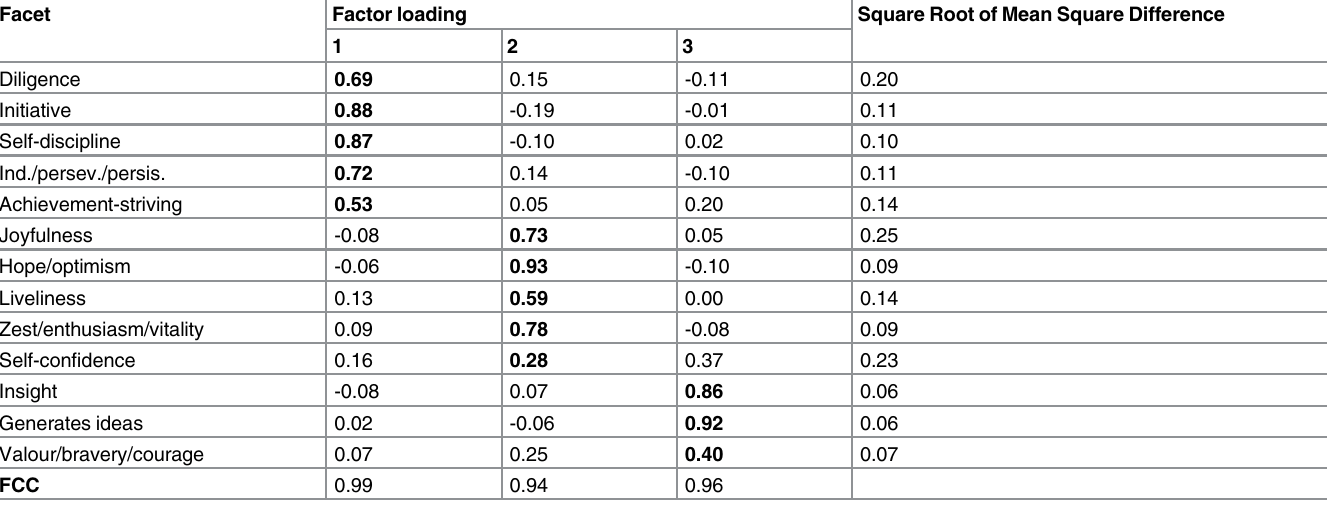
Table 5. Factor Loadings after Target Rotation and Congruence Coefficients in the Eugene-Springfield Community